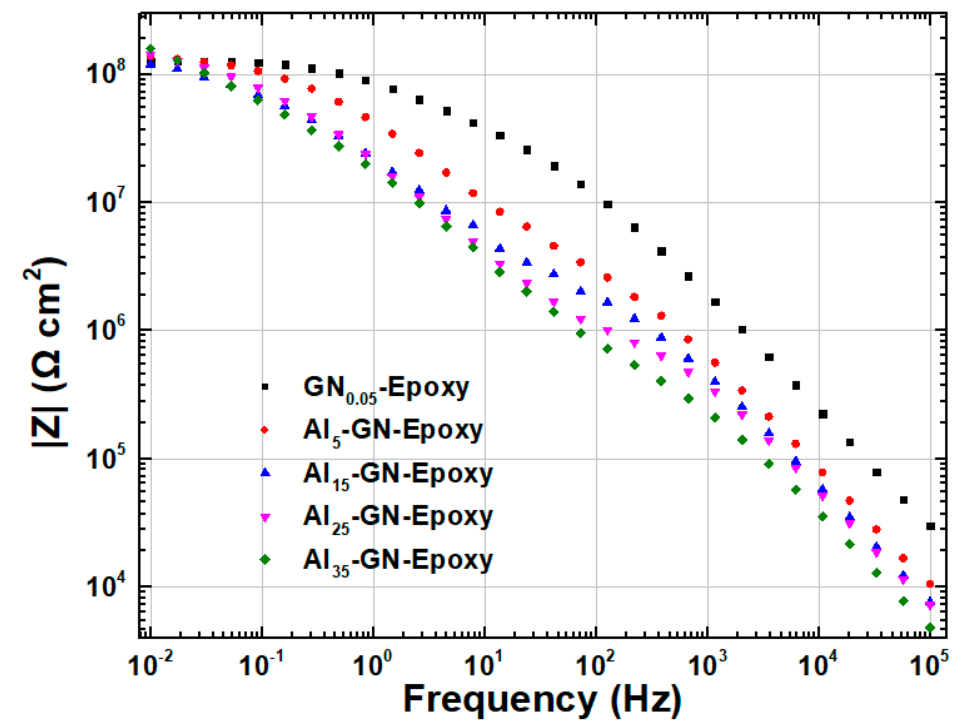
Figure 15. Bode plots of EIS for coatings filled with 0.05 wt.% of GN1100 and various contents (5, 15, 25 and 35 wt.%) of Al immersed in 3.5 wt.% NaCl solution.